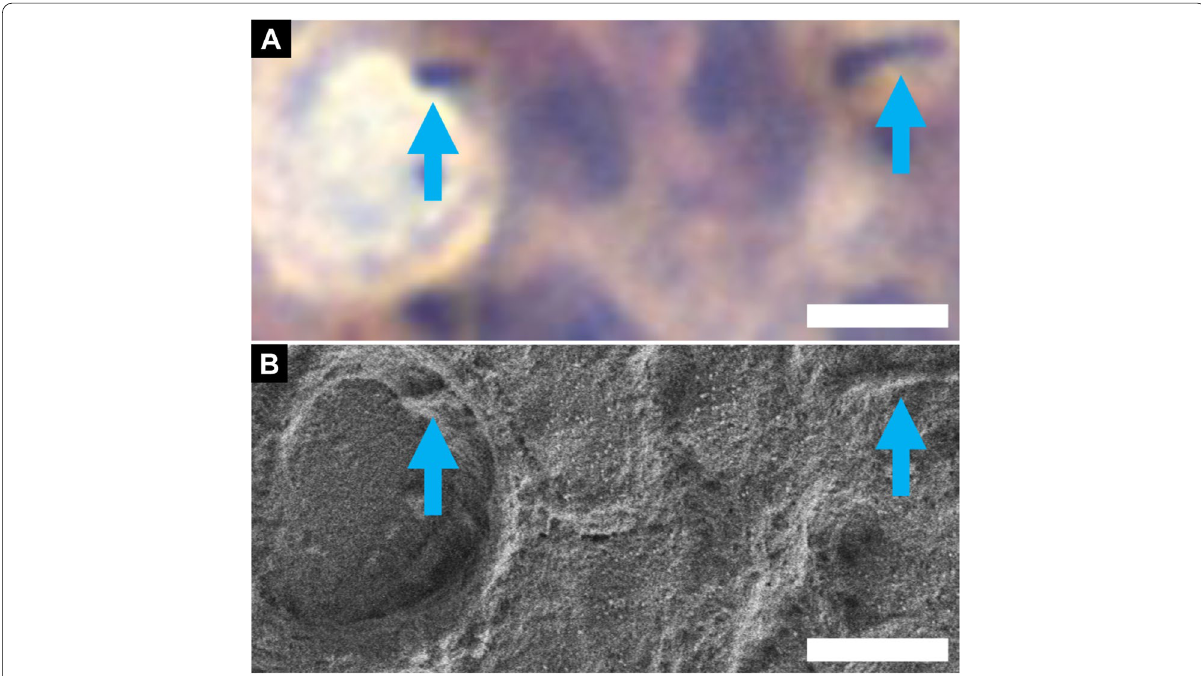
Fig. 6 Immunohistochemistry. A Light microscopy image of primary cilia (arrows) in human salivary gland tumors after ARL 13B immunohistochemistry. B Corresponding SEM image after the NanoSuit treatment. Bars the